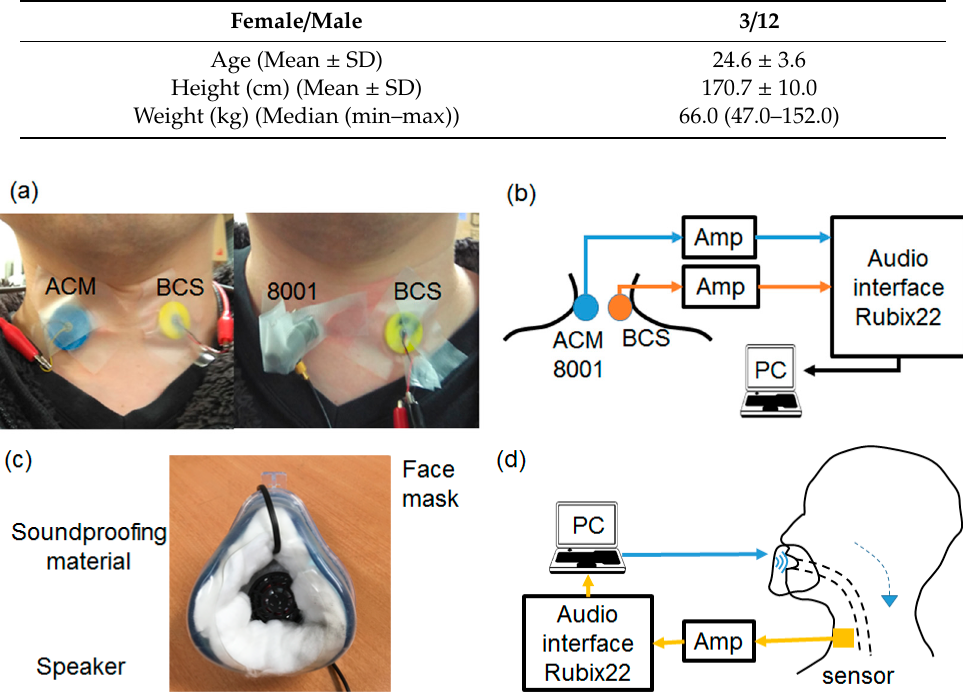
Figure 5. Actual tracheal sound observation system.( a ) A sensor is attached to the test subject (ACM and BCS on the left, type 8001 and BCS on the right). ( b ) Diagram of the actual measurement system. ( c ) Mask with the built-in speaker. ( d ) Diagram of the mask sound source measurement system.